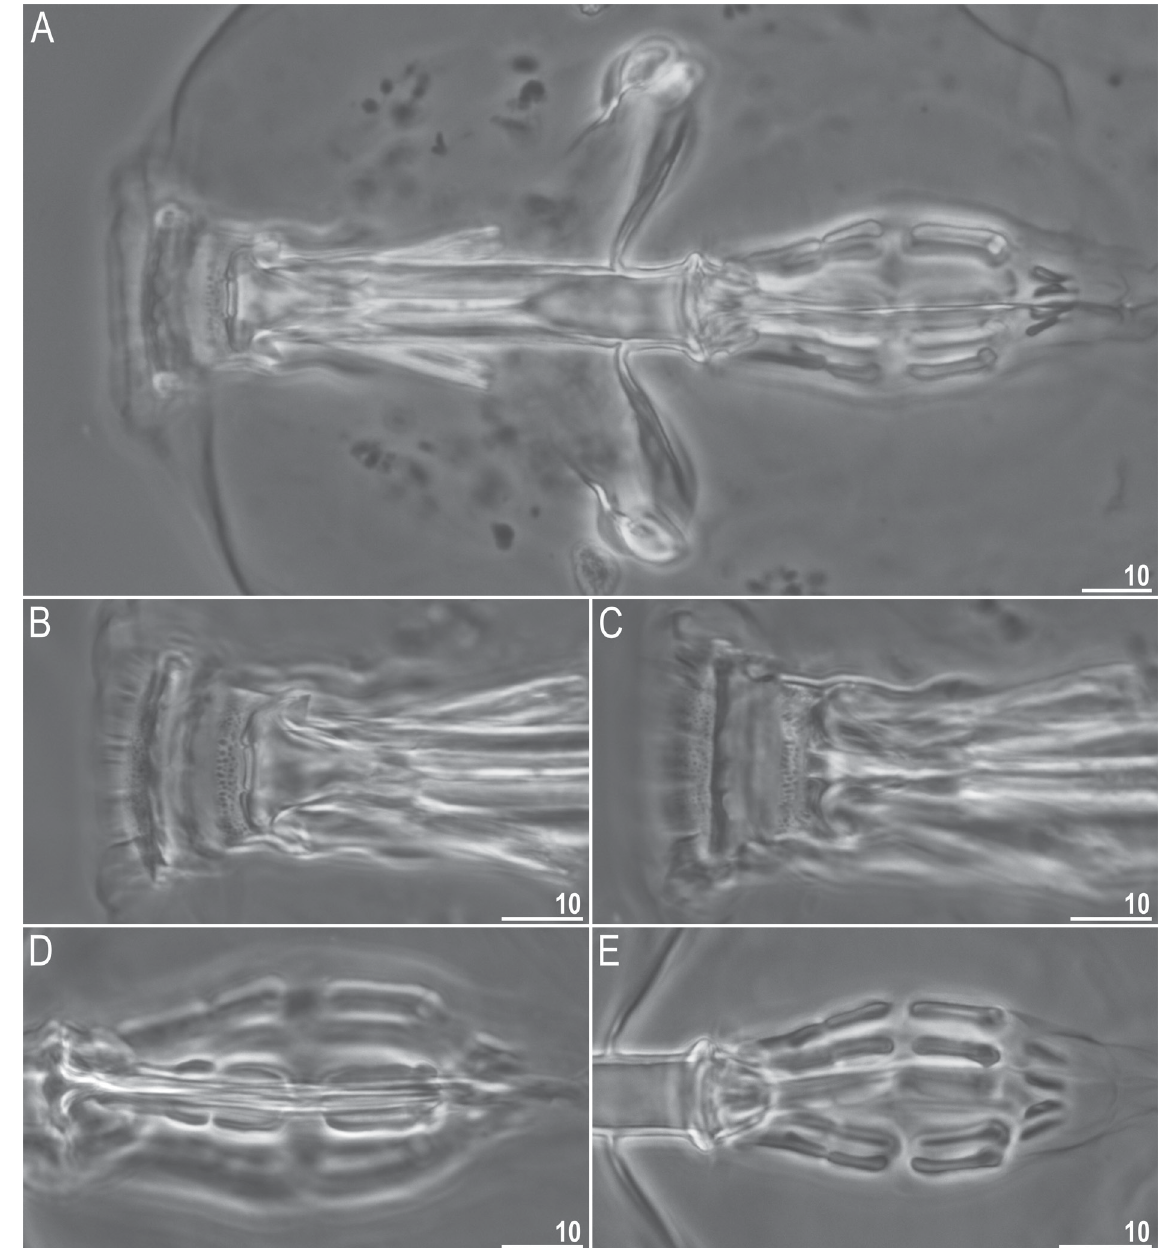
Fig. 10. Macrobiotus cf. recens Cuénot, 1932 , Gran Canaria, buccal apparatus and the oral cavity armature seen under PCM. A . Dorsal projection of the entire buccal apparatus. B–C . Dorsal and ventral view of the oral cavity armature, respectively. D–E . Placoid morphology. Scale bars in